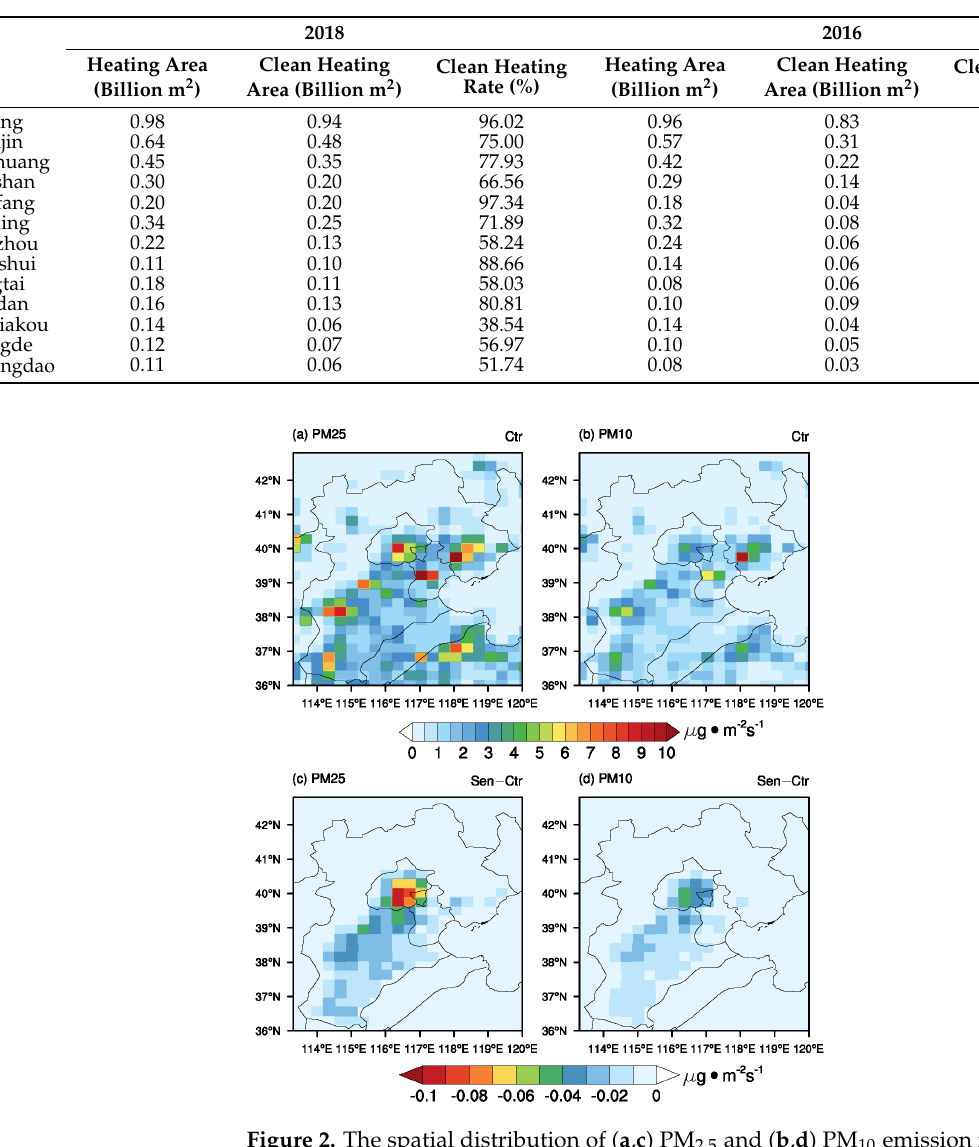
Table 1. Statistical results of heating and clean heating areas in 2016 and 2018 for the BTH region, and the residential coal-mitigation rate due to CTGC/CTEC projects.